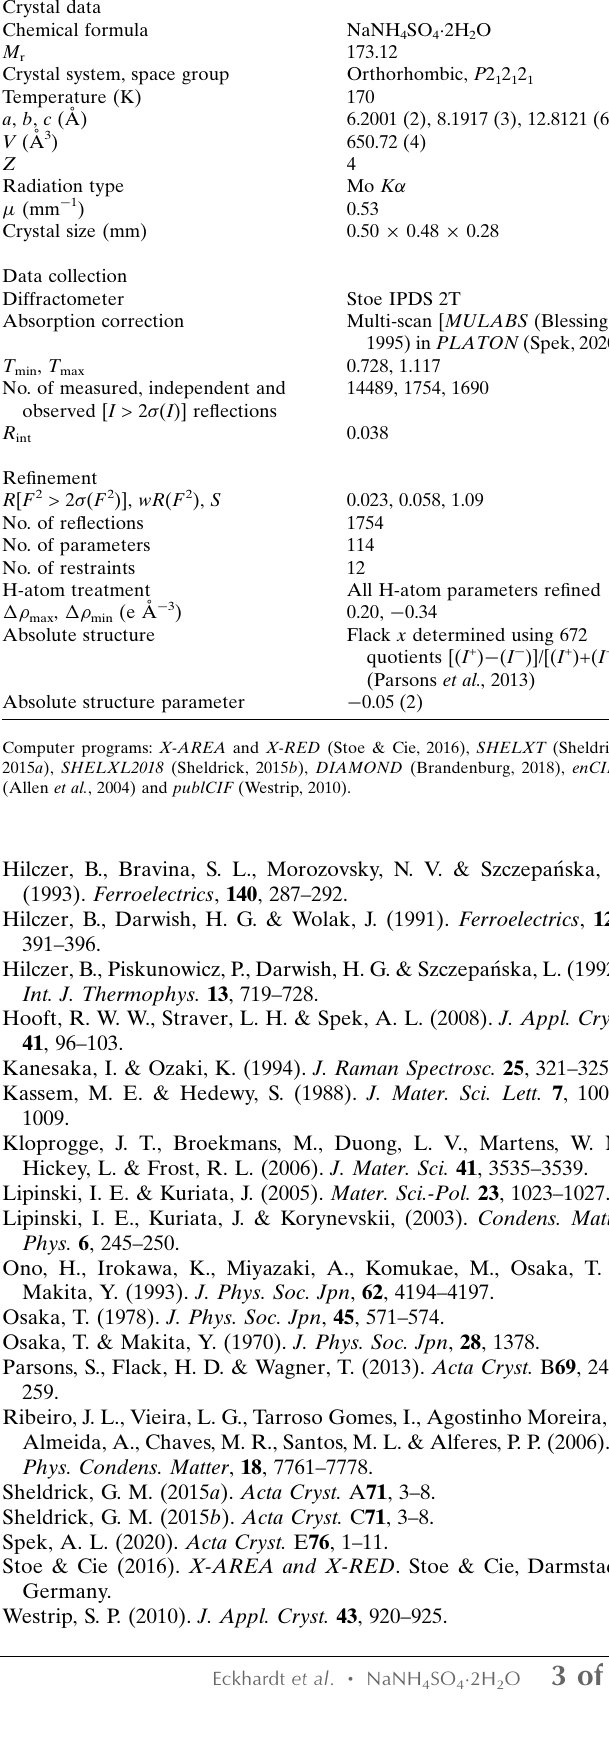
Crystal data Chemical